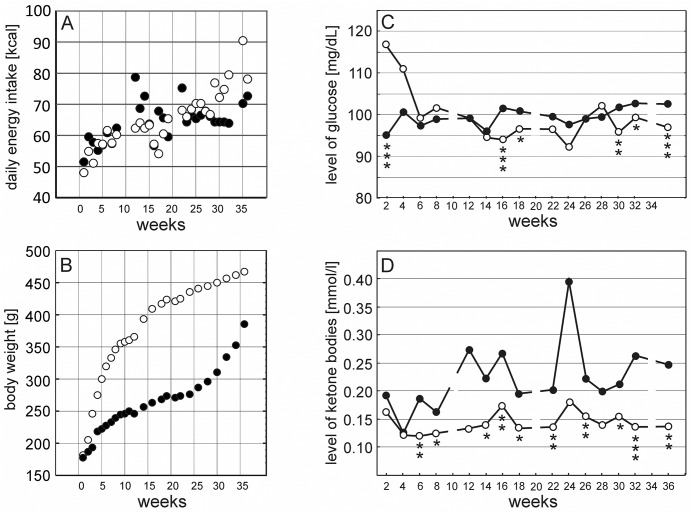
Daily energy intake (A), changes in body weight during the experiment (B), changes in glucose blood levels (C), and changes in blood levels of ketone bodies (D) in controls and HFD-fed rats.*P<0.05, ***P<0.01. The “spikes” in levels of ketone bodies were caused by short-lived increases in concentrations of ketone bodies in single animals.